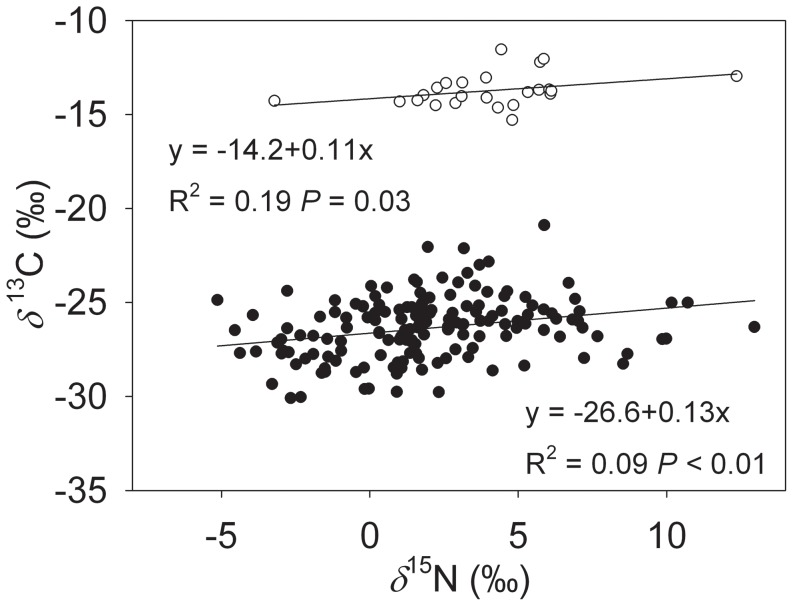
Correlations between δ
13C and δ
15N values of the studied C3 (filled circles) and C4 plants (open circles).Linear regression equations, R
2 and P values are provided.